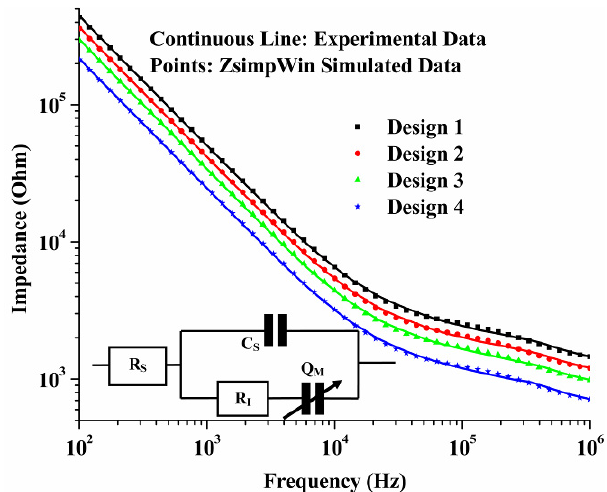
Fig. 4: Bode Plot of Blood with its equivalent